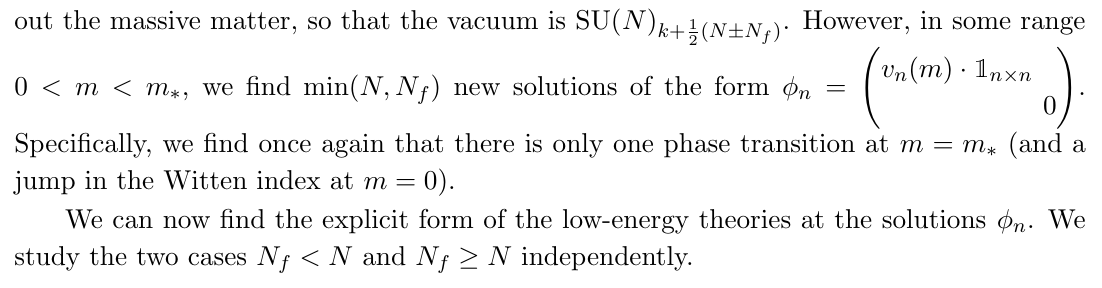
Figure 5 . Phase diagram for an N = 1 SU( N ) matter multiplets. The precise form of the low-energy theories in the intermediate phase is discussed in the